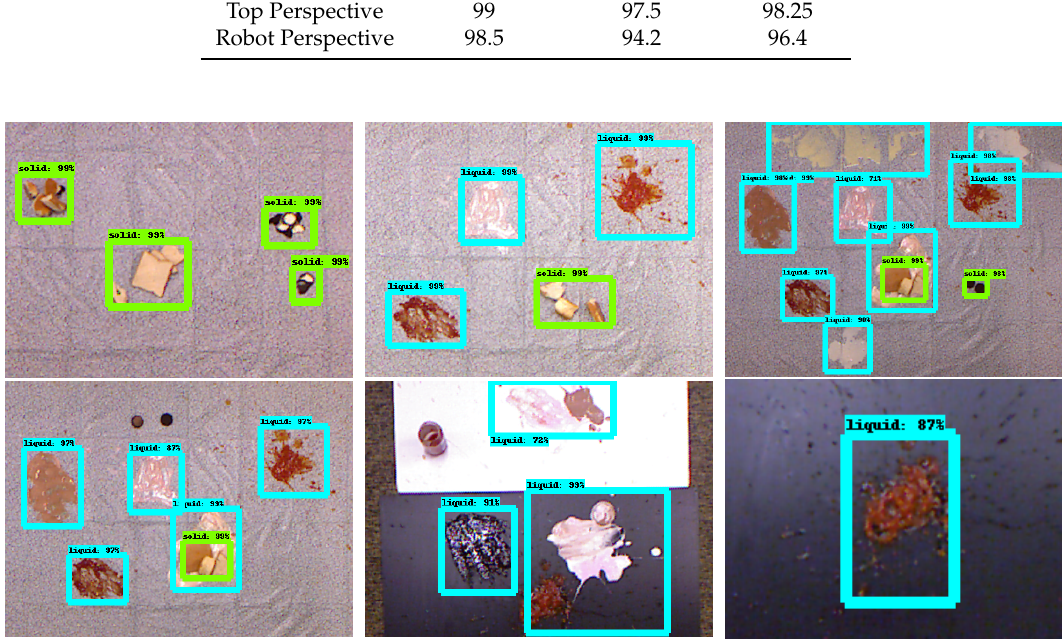
Figure 4. Overhead View Results.